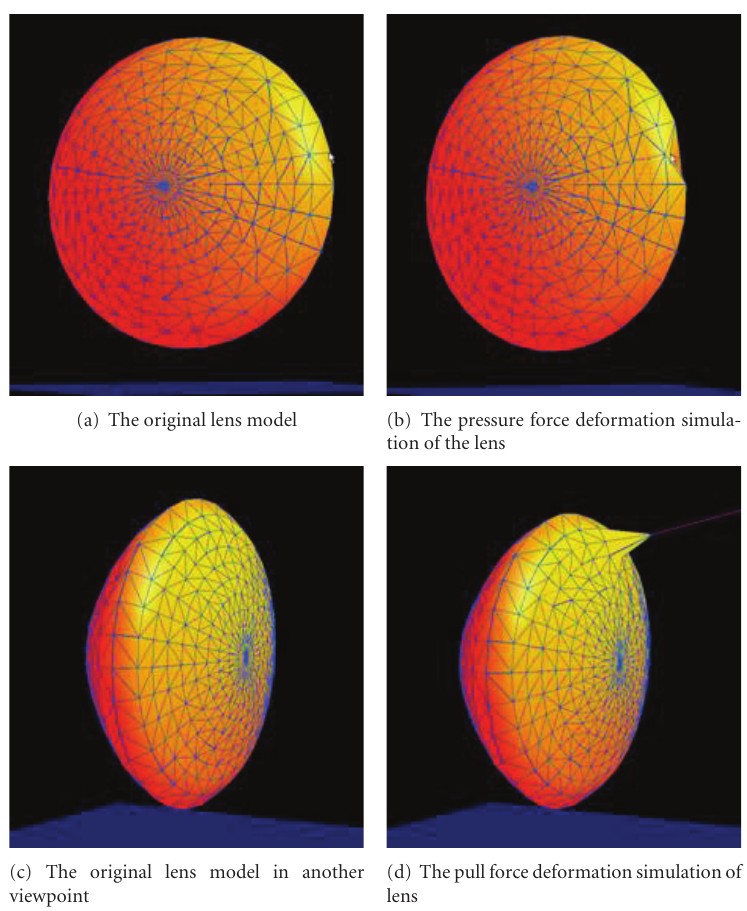
Figure 9: Simulation of human lens deformation.